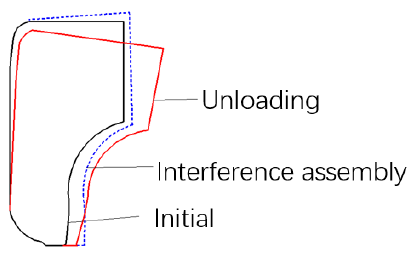
Figure 24. Changing process of the inner ring section (deformation scale × 100).